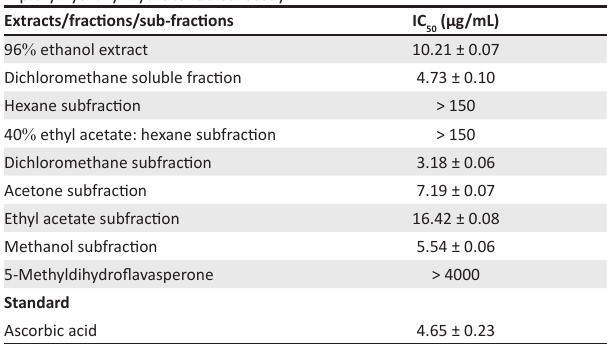
of ethanol extract, dichloromethane fraction, dichloromethane TABLE 3: The IC 50 subfractions and ascorbic acid (standard) as determined using the 2,2-diphenyl- 1-picrylhydrazyl hydrate radical